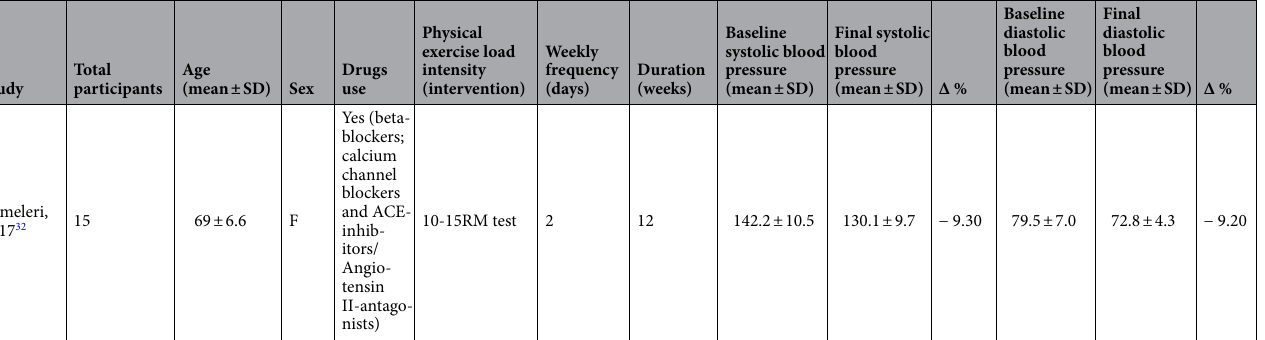
Table 1. Data referring to the total of individuals, age, average blood pressure, intervention data, and use of drugs of study. RM repetition maximum, ACE Angiotensin-converting enzyme, ACEI Angiotensin-converting enzyme inhibitor, Δ % variation of arterial hypertension. Age and Blood Pressure values were presented with mean ± SD (standard deviation). M male, F female. Unspecified = does not say which drug was used.